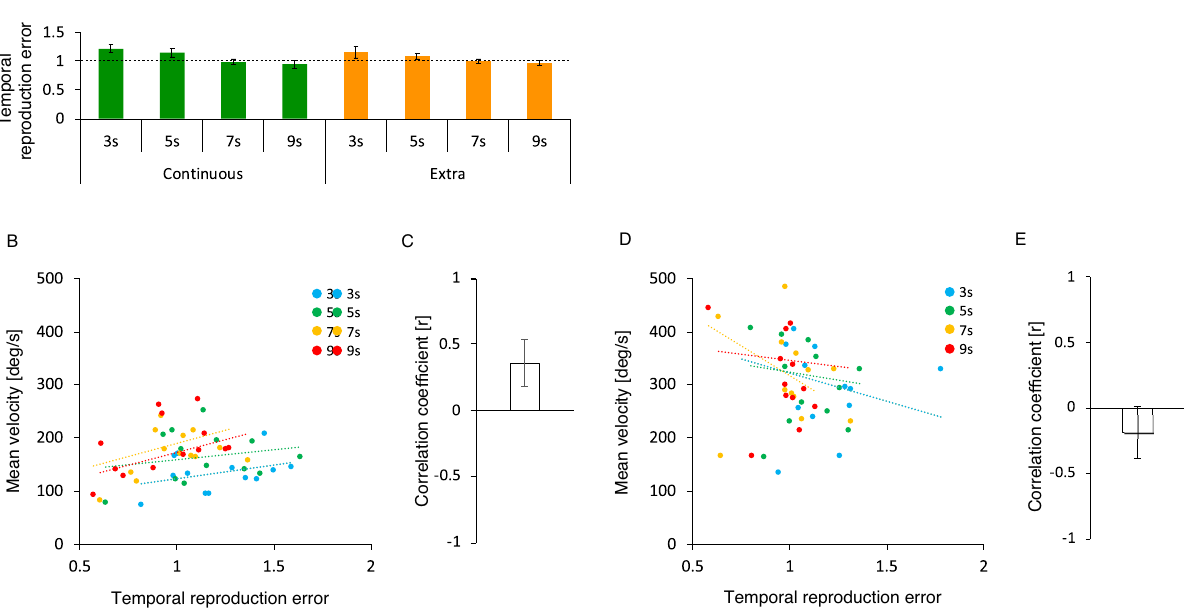
Figure 3. Average temporal reproduction error for the continuous and extra continuous action conditions ( A ), regression lines fitted to each duration condition’s temporal reproduction error, and steering wheel velocity for the continuous action condition ( B ) and for the extra continuous action conditions ( D ), and its average correlation coefficient for the continuous action condition ( C ) and for the extra continuous action conditions ( E ). Statistical comparisons revealed that, compared with 1 (a dotted line), the temporal reproduction errors in both conditions were higher in the 3-s and 5-s conditions, but identical in the 7-s and 9-s conditions ( A ). The slopes of the regression lines appeared to be positive in the continuous action condition ( B ) and negative in the extra continuous action condition ( D ), and the average correlation coefficient was significantly higher than 0 in the continuous action condition ( C ) but marginally lower than 0 in the extra continuous action condition. Error bars represent 95% confidence